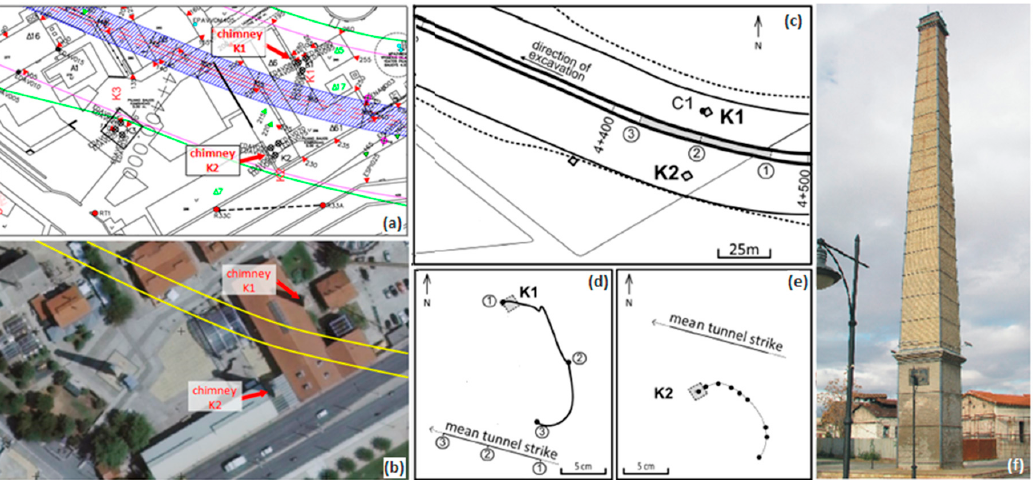
Figure 2. Contrasting evidence of ground loss during the excavation of the Athens Metro Line 3in the Gazi area from buildings and chimneys, based on geodetic monitoring. ( a ) Benchmarks on buildings (black and red symbols) indicate limited ground loss, but benchmarks on the 30 m-high chimneys indicate a 3-D deformation, summarized in ( d ), ( e ) and tilting up 0.75%. The tunnel path is shaded, and the predicted influence limits are shown by purple and green lines. ( b ) Aerial view of the Gazi area (map of the Hellenic Cadastre) of the area in ( a ). The excavation route is marked by two yellow curves. ( c ) A simplified sketch of the area around chimneys K1 and K2 showing the advancement of the tunnel front. Predicted limits of the tunnel influence zone are marked by continuous and dotted lines. ( d , e ) Summary of observations of movement of the center of gravity of chimneys K1, K2 near their top. ( f ) Side view of the K2 chimney; in the background, some of the buildings which provided evidence of minimal subsidence. Based on [17] and unpublished data.